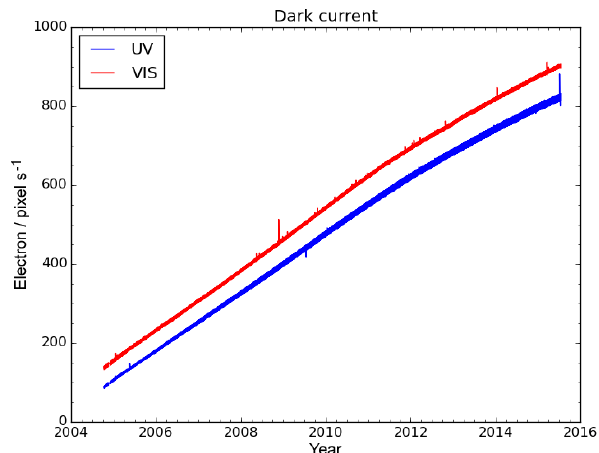
Figure 12. The average dark currents for two CCDs.